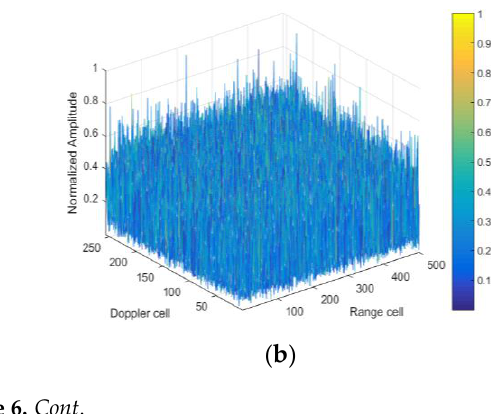
Figure 6. Coherent integration for a maneuvering target. ( a ) The result after pulse compression; ( b ) the integration result of moving target detection (MTD); ( c ) the velocity estimation result of the scaled inverse Fourier transform (SCIFT); ( d ) the integration result of the SCIFT.